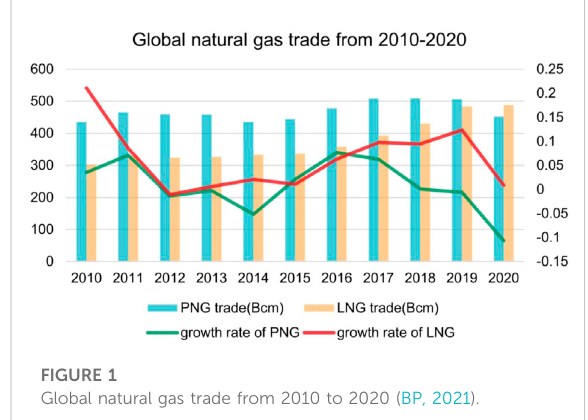
FIGURE 1 Global natural gas trade from 2010 to 2020 (BP, 2021).